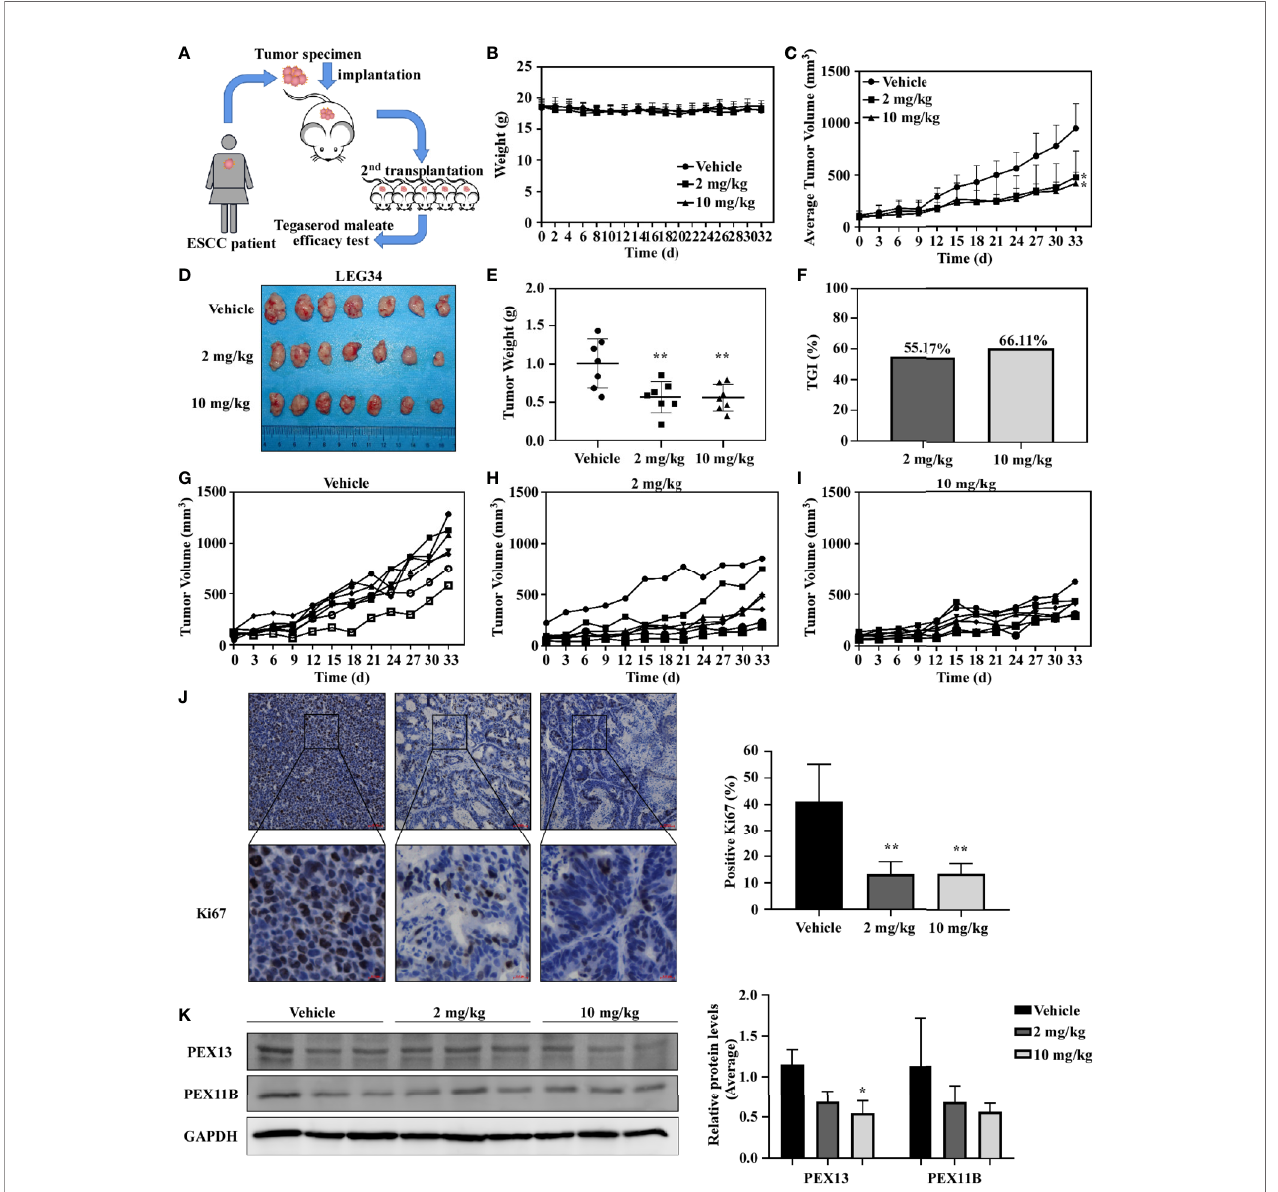
FIGURE 6 | Tegaserod maleate inhibits the growth of ESCC PDX in vivo . (A) Schematic diagram to evaluate the effect of tegaserod maleate on tumor growth of ESCC PDX. (B) Tegaserod maleate has no toxic effects on the body weight of mice. Body weights were obtained from treated or untreated groups mice every two days. (C) The average tumor volume of each group was measured every three days. (D) The photograph shows tumors in PDX mice treated with vehicle or tegaserod maleate (2 mg/kg or 10 mg/kg). (E) On the 33rd day, the tumor weight was measured. The tumor volumes in tegaserod maleate-treated mice was signi fi cantly reduced (** p < 0.01). (F) The tumor growth inhibition (TGI) with 2 mg/kg and 10 mg/kg tegaserod maleate treatment. (G) Growth curves of individual tumors in the vehicle group, (H) 2 mg/kg tegaserod maleate treated group and (I) 10 mg/kg tegaserod maleate treated group. (J) Immunohistochemical staining with Ki67 of tumor tissues in treated or untreated groups (left panel). The number of Ki67 staining positive cells was counted from the immunohistochemical results (right panel) (n = 3, ** p < 0.01). (K) The protein levels of PEX13 and PEX11B in tumor tissues were detected by western blotting. Image J software program was used to measure band density. The average relative protein levels of PEX13 and PEX11B are shown (* p <